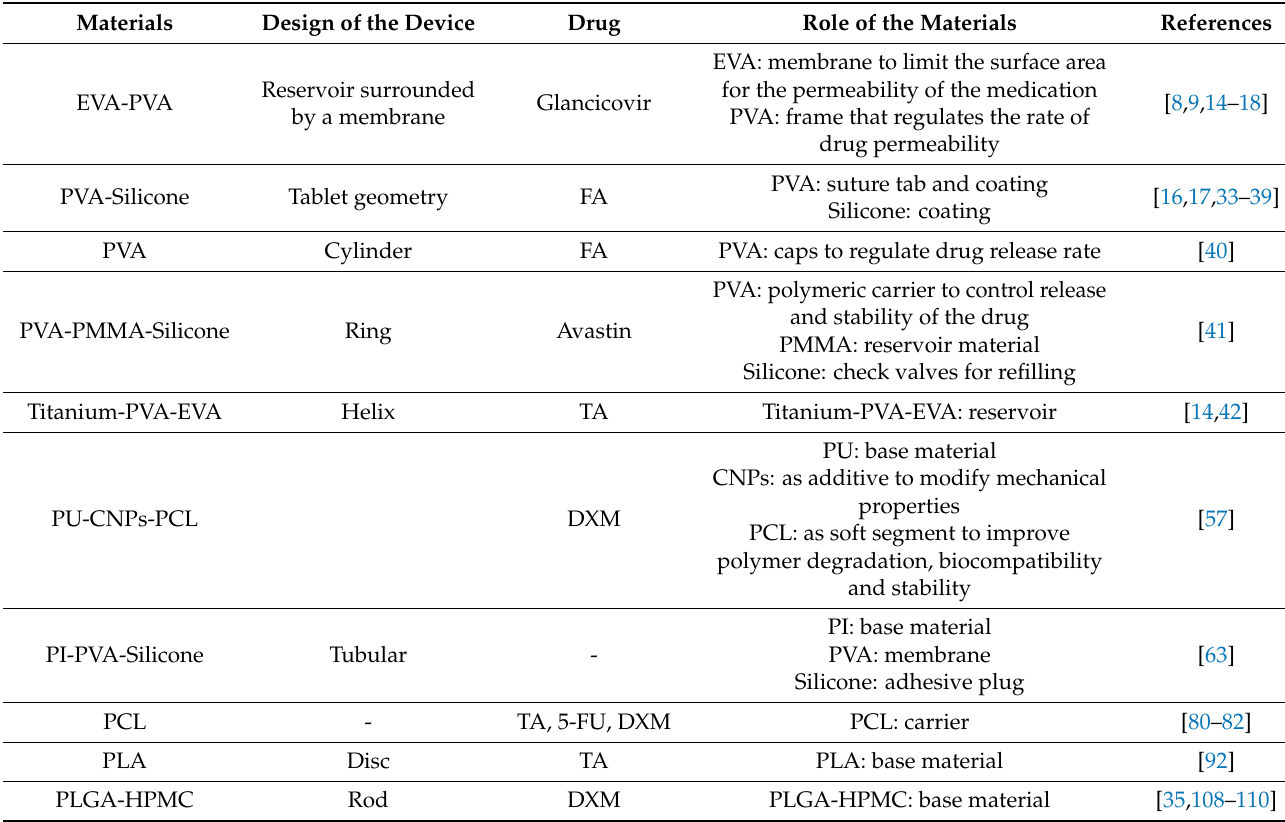
Table 6. Geometry and role of the materials used to build polymeric